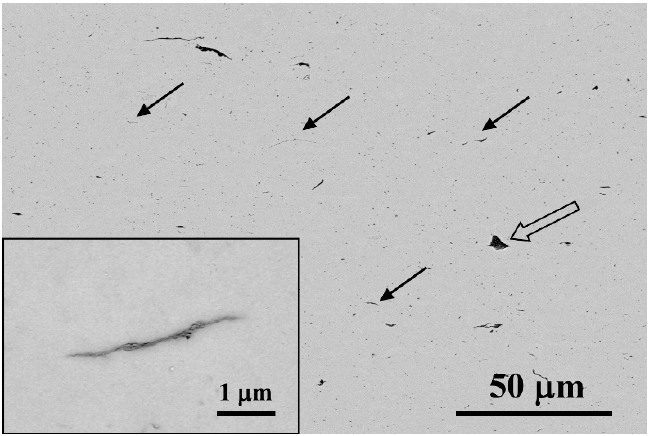
Figure 5. BSE ‐ SEM micrographs of the polished c.s. surface of the sintered composite. Figure 5. BSE-SEM micrographs of the polished c.s. surface of the sintered